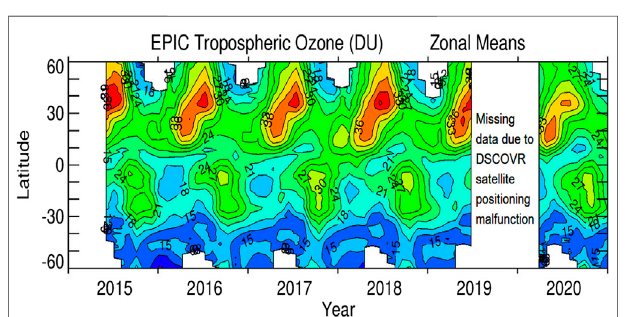
FIGURE 12 | EPIC monthly zonal mean TCO as a function of time and latitude. These TCO values were adjusted with CWF to account for reduced sensitivity to the boundary layer. Results are shown with 3 DU